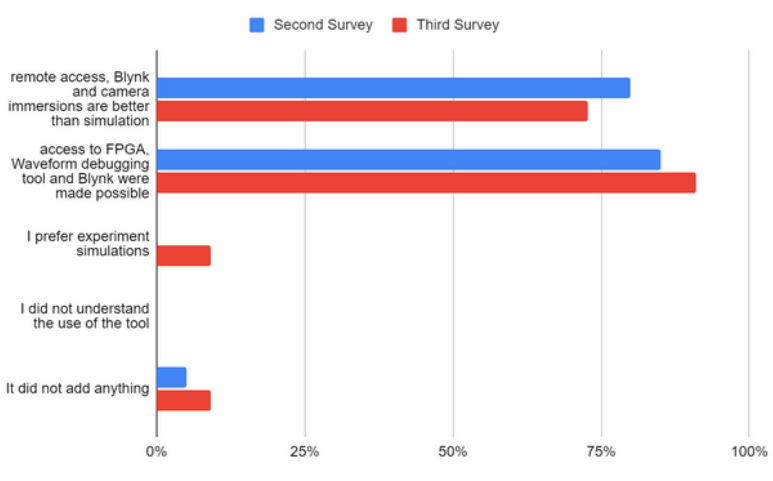
Figure 7. Student perceptions of the LabEAD